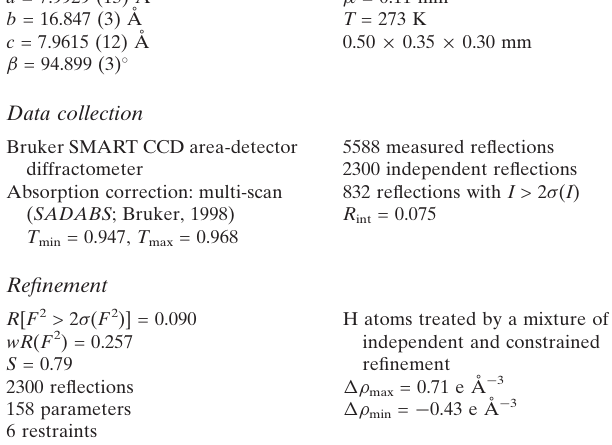
Data collection Bruker SMART CCD area-detector diffractometer